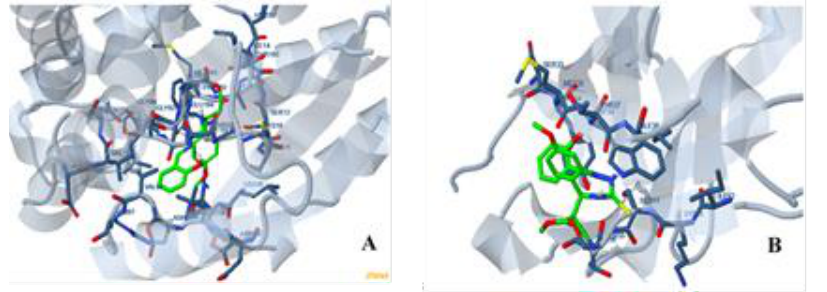
Figure 4. The 3D molecular docking of MTSC ligand against 3hb5-oxidoreductase protein ( A ) and speckle-type POZ protein (SPOP) protein binding ( B ). Table 7. Docking scores of the MTSC ligand in the oxidoreductase protein and SPOP binding protein sites. Est. Free Energy